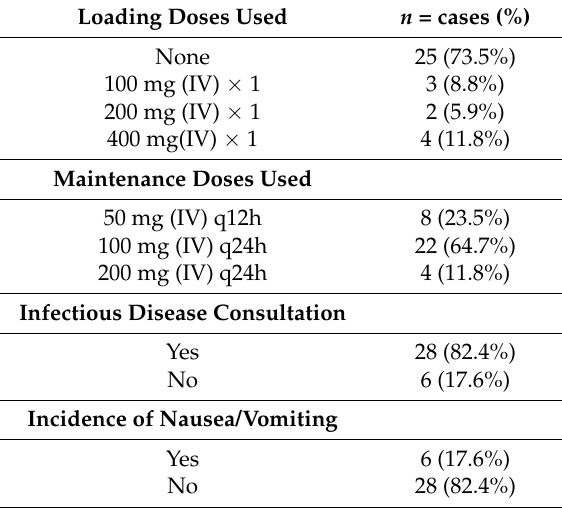
Table 2. Winthrop University Hospital’s recent tigecycline experience: secondary